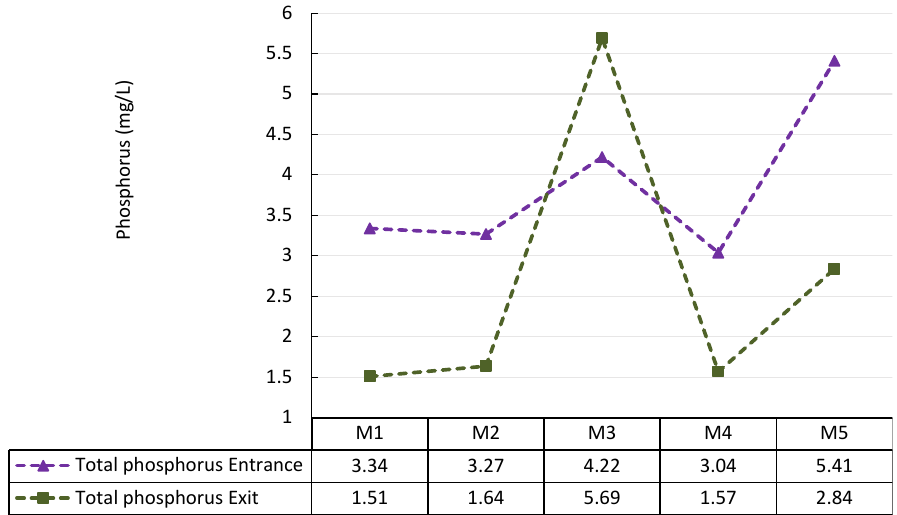
Fig. 7: Phosphorus content of the treated and untreated effluents and the 5 samplings.